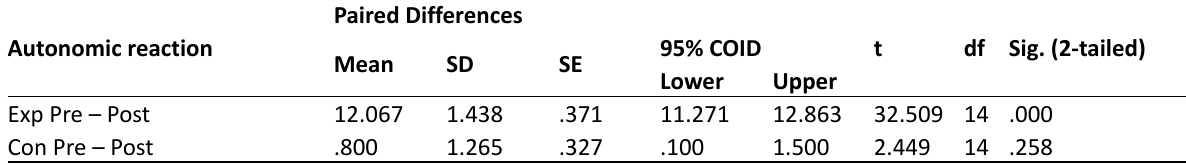
Table 5. Pre and post mean differences of experimental and control group for water retention Paired Differences Water retention